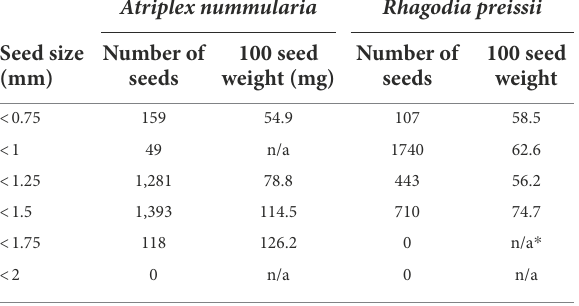
TABLE 7 The distribution of 3,000 seeds of each species into different size groups. Atriplex nummularia